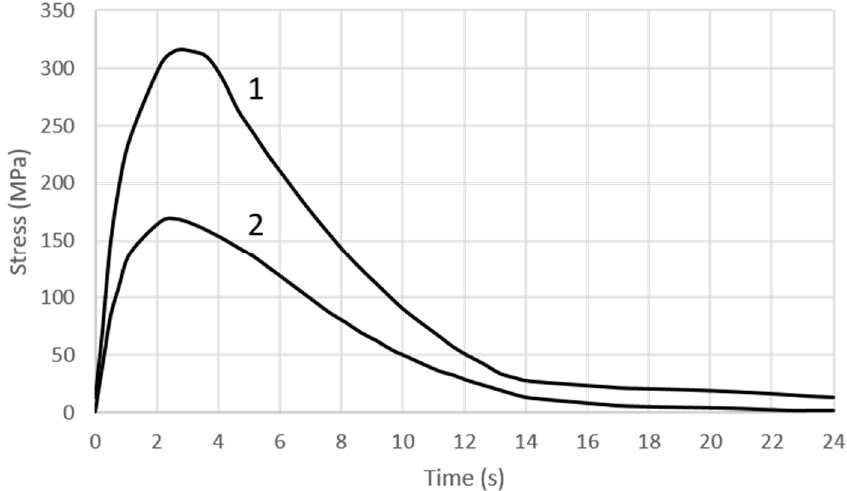
Figure 12. Changes in the stress-state component σ x : 1—in the area of change of the cooling channel trajectory; 2—on the surface of the rectilinear section of the cooling channel.